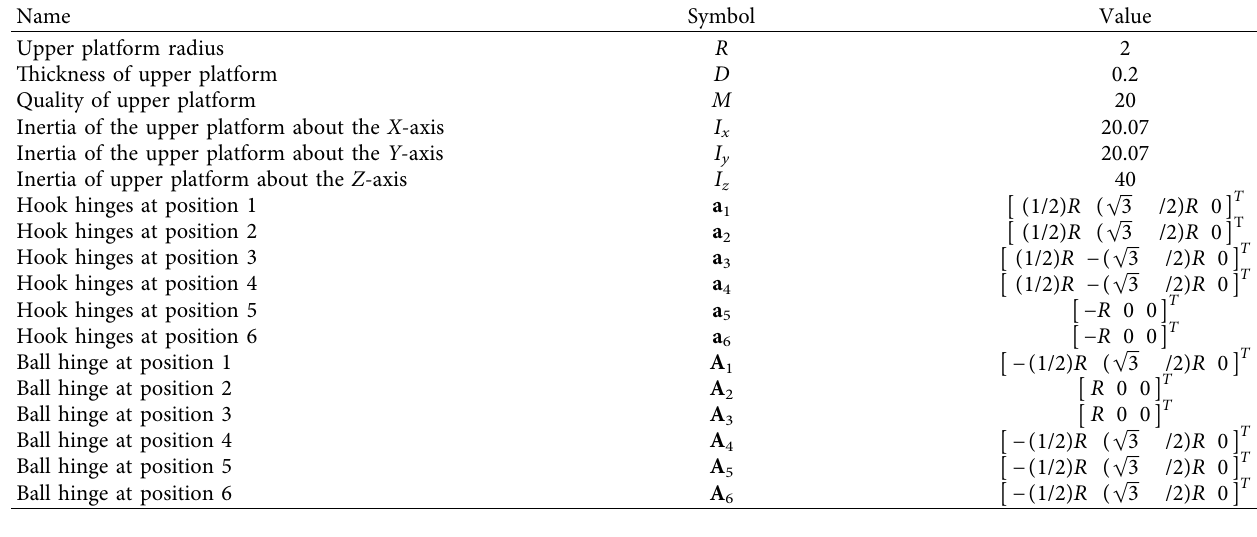
Table 1: Physical parameters of electrohydraulic Stewart platform (unit: